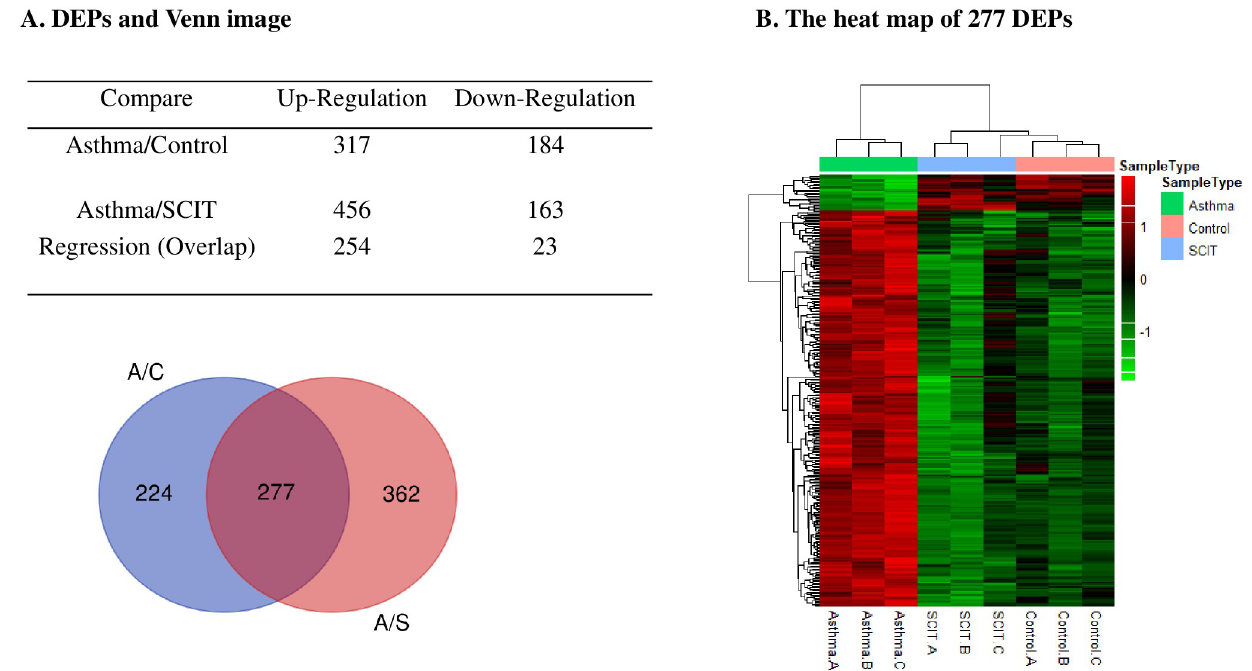
Fig 4. Identification of differentially expressed proteins before and after SCIT. A. Identification of differentially expressed proteins (DPEs), the Venn image; There were 501 differentially expressed proteins between the control group and the asthma group, of which 317 proteins were upregulated and 184 were proteins downregulated in the asthma group (shown in blue). 639 proteins (456 downregulated and 163 upregulated proteins in the asthma group) were differentially expressed after SCIT (shown in red). B. The heat map of 277 regression DEPs. The 277 overlapping proteins were significantly changed in the asthma condition compared with those of the control condition and then returned to levels similar to the related nondisease condition (just as the control condition) after receiving SCIT.